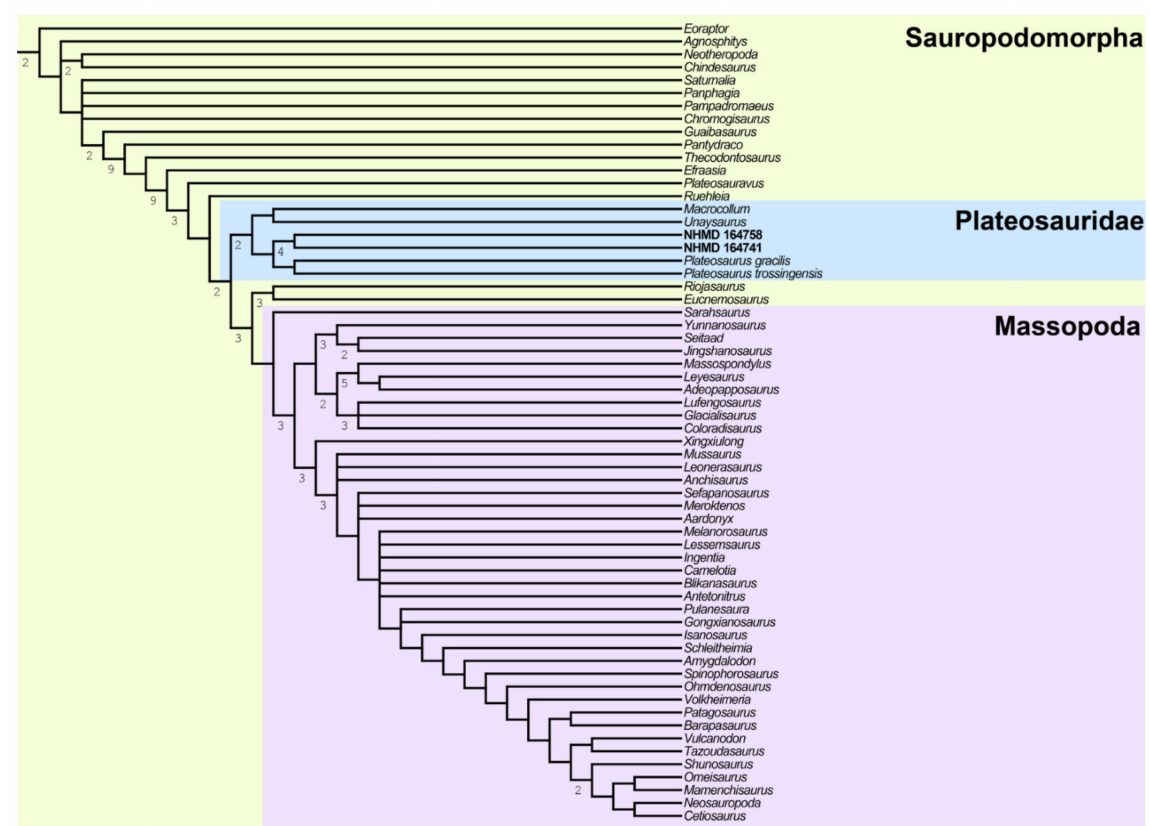
Figure 36. Strict consensus tree of the Greenland specimens. Strict consensus tree of Sauropodomorpha including the Greenland specimens as separate OTUs. Bremer support number (>1) are found under the